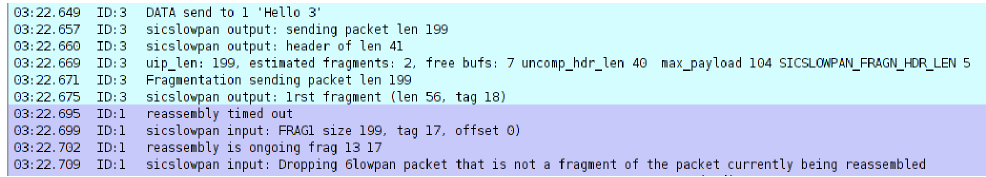
Figure 13. Log listener—packet fragmentation with attack.